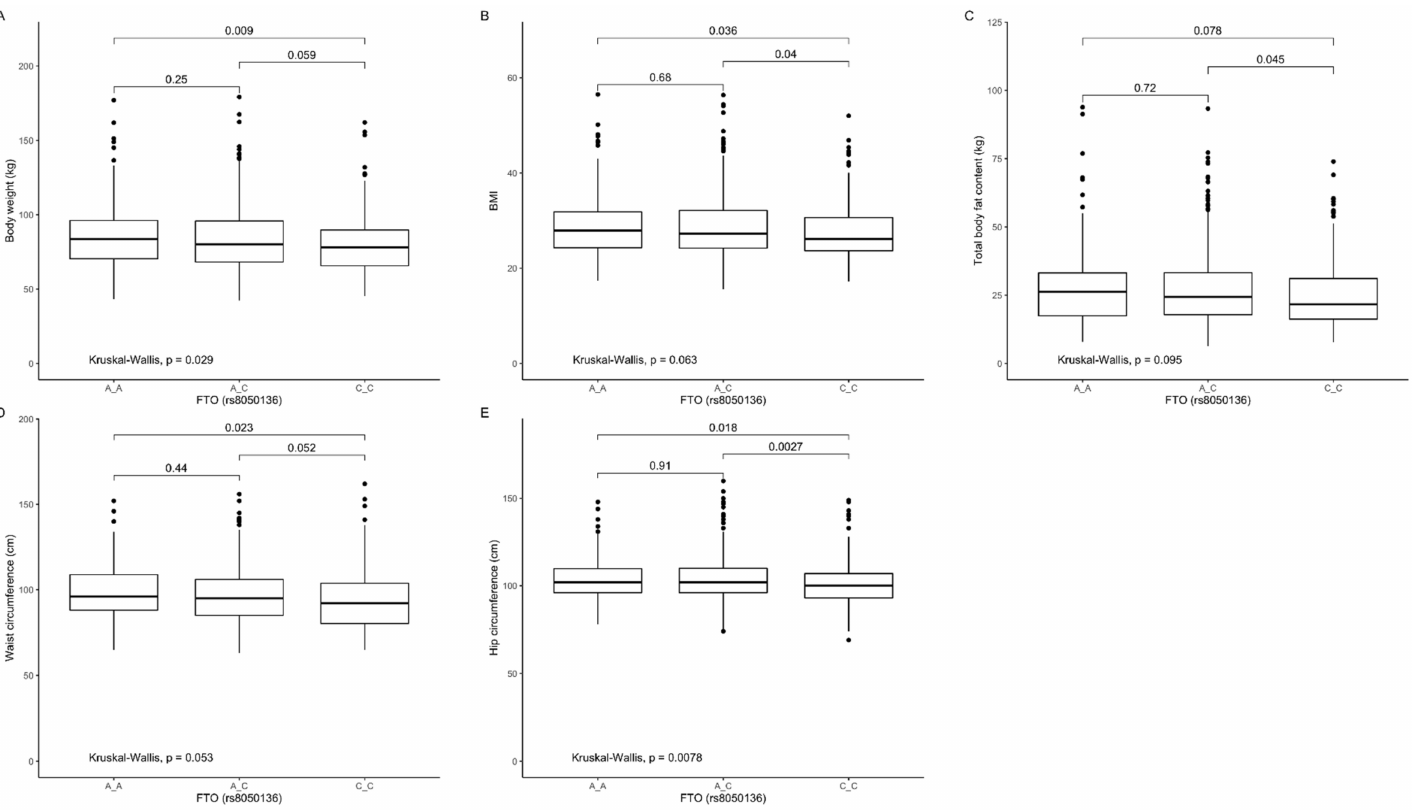
Figure 5. Association of FTO genotypes rs8050136 with ( A ) body weight (kg), ( B ) BMI (kg / m 2 ), ( C ) total body fat content (kg), ( D ) waist circumference (cm 3 ), ( E ) hip circumference (cm 3